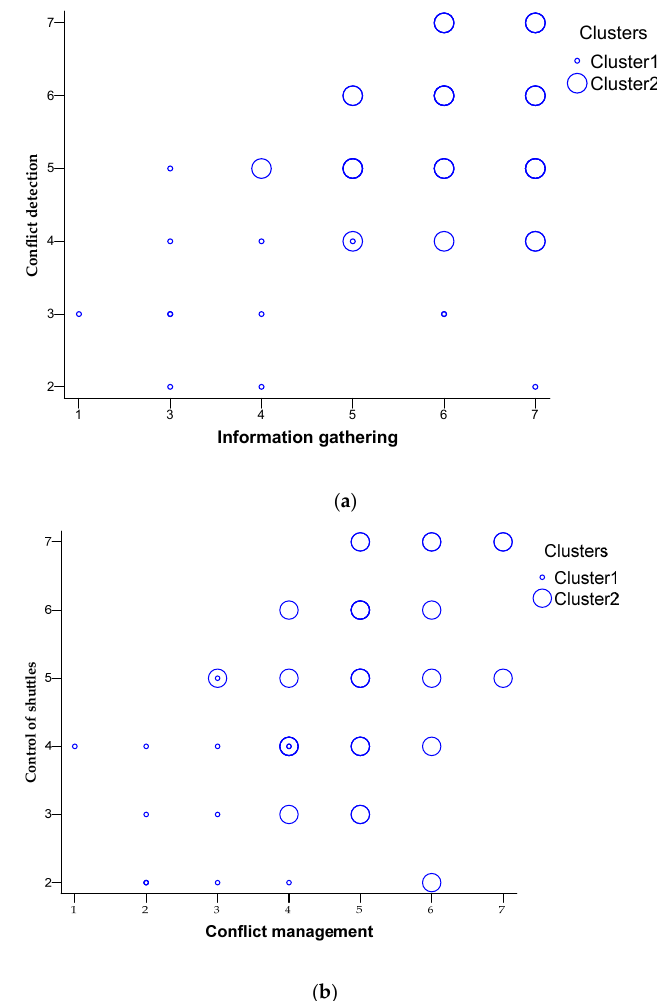
Figure 11. Graphical representation of the clusters formulated from the subjective evaluation of the HO KHC. ( a ) Information gathering and conflict detection. ( b ) Conflict management and control of the shuttles.